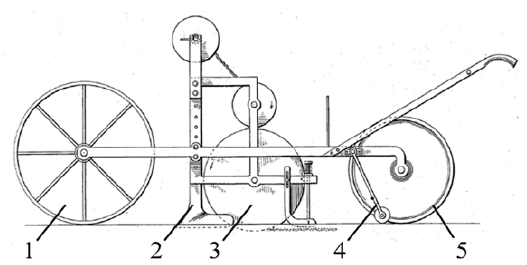
Figure 8. Seeder tape planter designed by Sanford [89]. 1, front-wheel 2, furrow opener 3, rope guiding wheel 4, scribing wheel 5, pressing wheel.